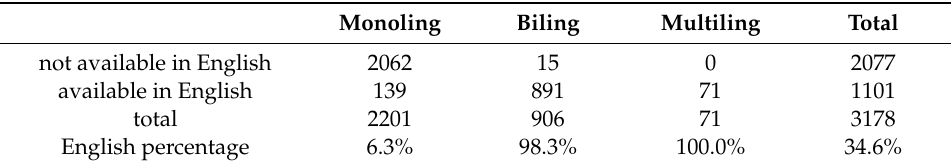
Table A6. English language availability (bg).